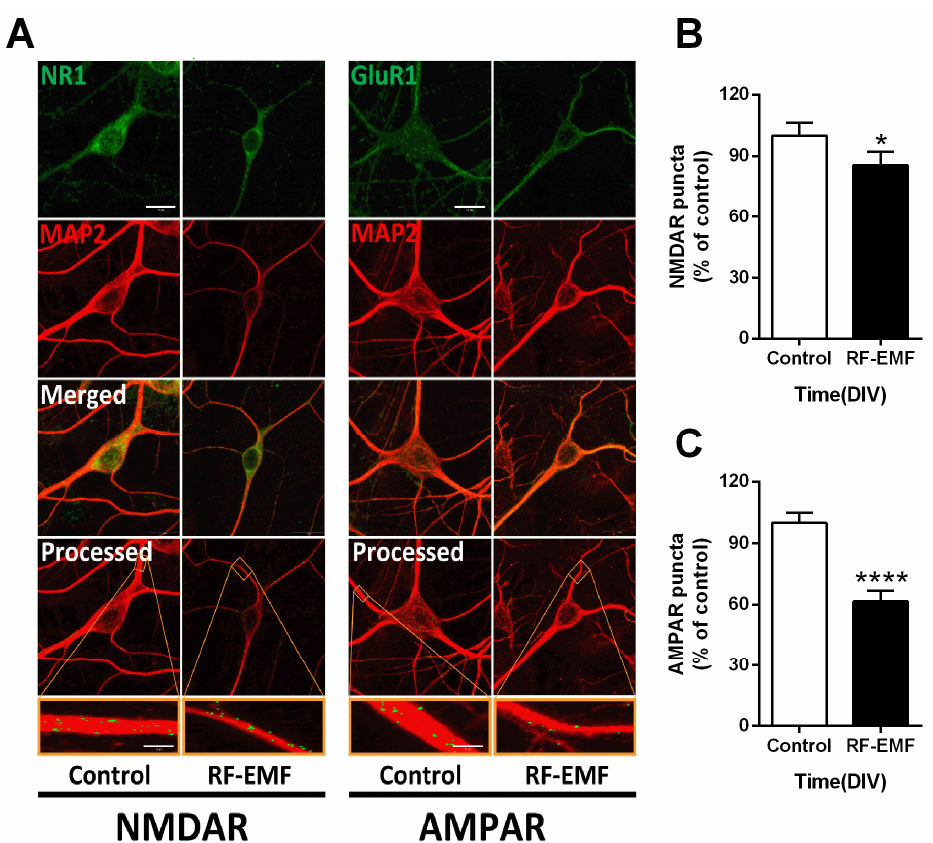
Figure 5. Exposure to RF-EMF decreased the expression of NMDAR and AMPAR. ( A ). Confocal images display hippocampal neurons expressing AMPAR (GluR1, green) or NMDAR (NR1, green) with MAP2 (red). Images of GluR1 and NR1 with MAP2 were analyzed using ImageJ. ( B , C ). Summary of changes in the number of GluR1 and NR1 punctae. Data are expressed as means ± SD. Statistical significance was evaluated using the Student’s t -test. * p < 0.05, **** p < 0.0001 vs. control (control n = 18 mice, RF-EMF n = 18 mice). Scale bars = 15 μm.